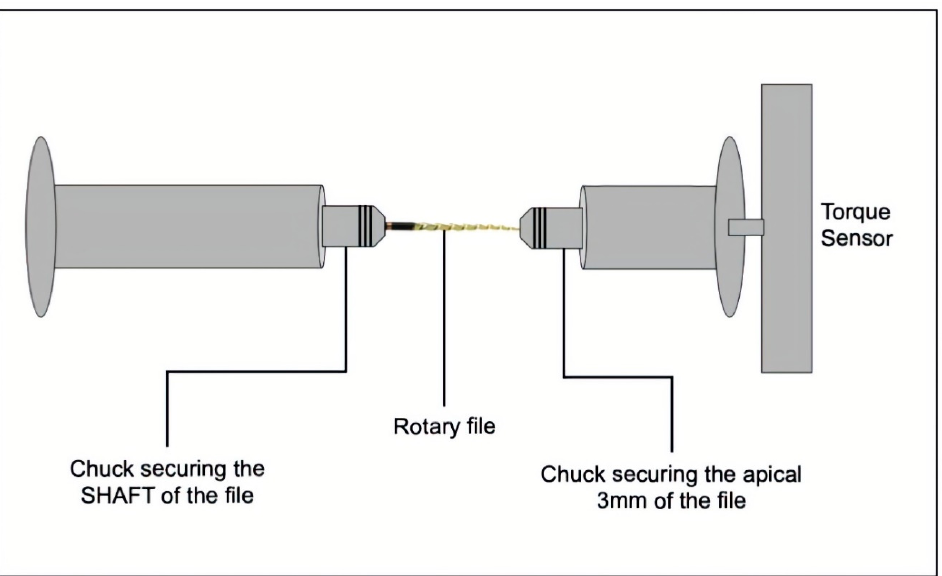
Figure 2. A schematic set-up for torsional testing of the files.